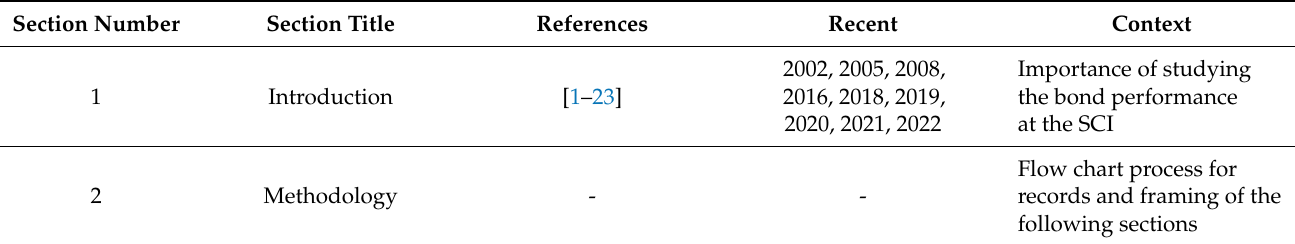
Figure 1. Flow chart of the review methodology. Table 1. Summary of the manuscript